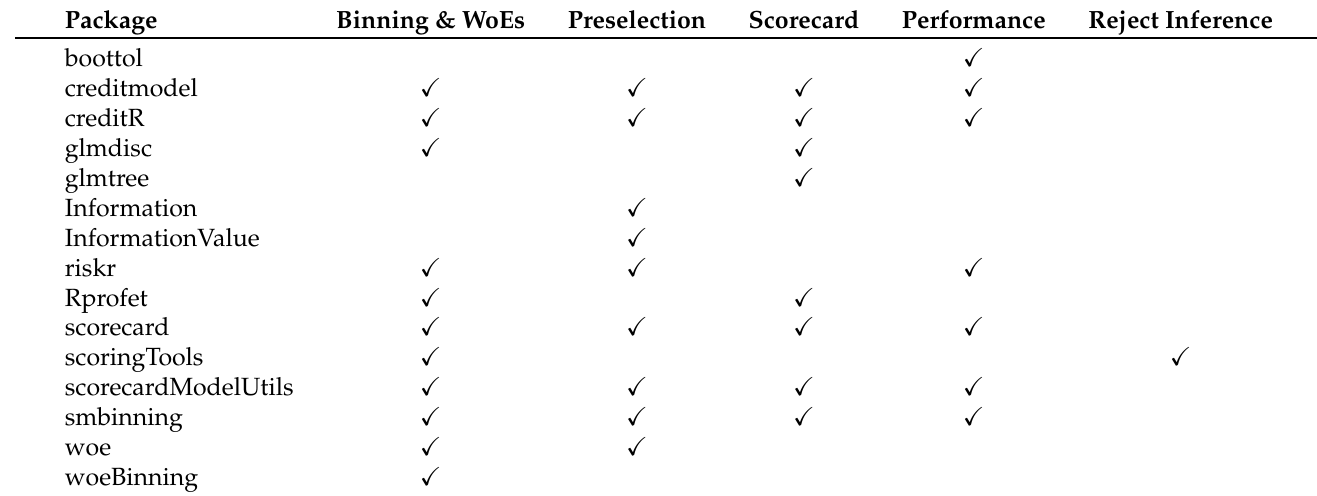
Table 6. Overview of R packages with the explicit scope of scorecard modelling and addressed stages of the development process.